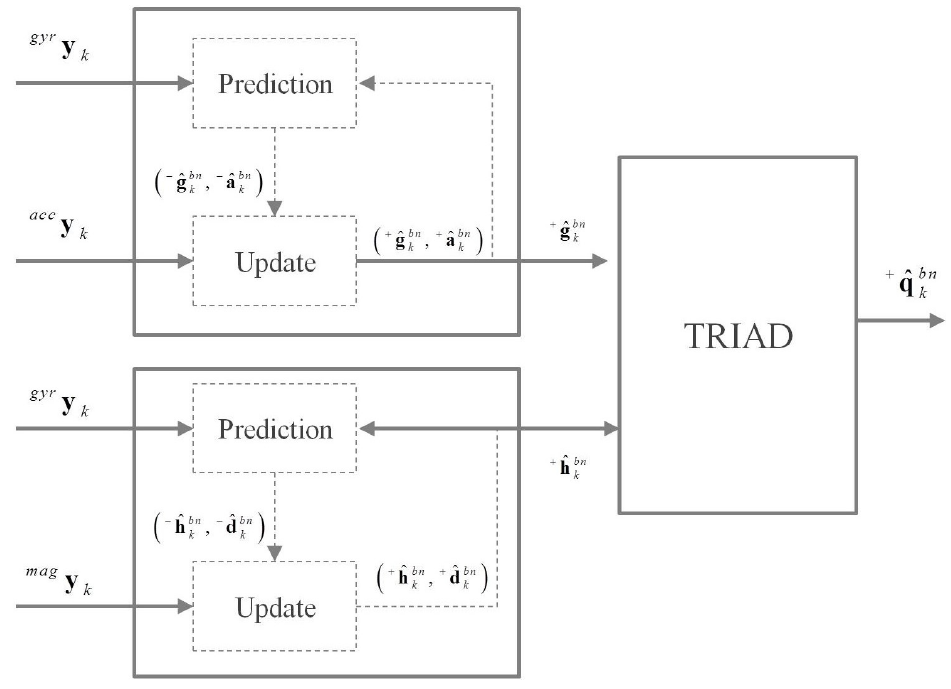
Figure A2. Overall workflow of the orientation estimator proposed in [9].